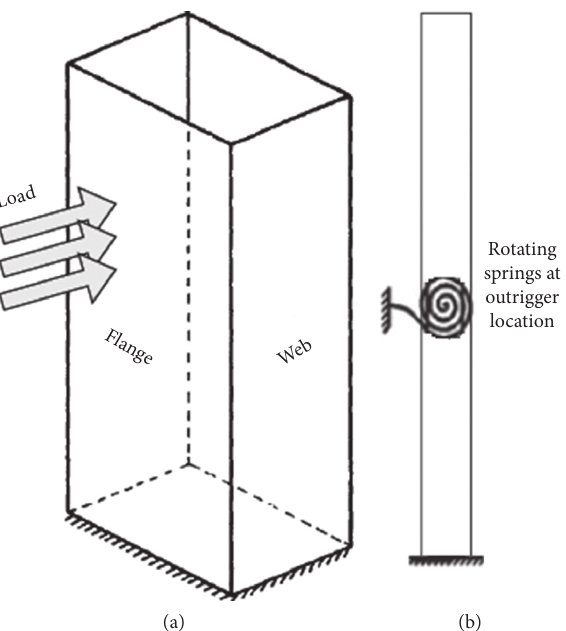
Figure 3: (a) The equivalent hollow section beam. (b) The equivalent impact of the core and outrigger on the hollow section beam.